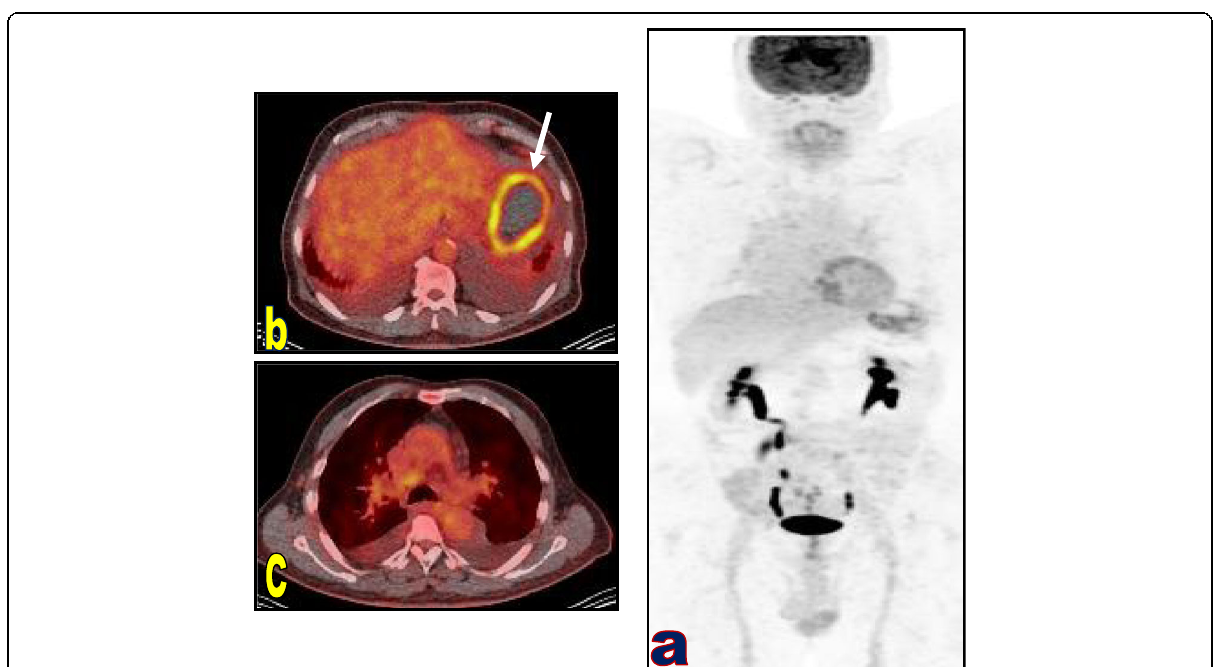
Fig. 6 3D MIP ( a ) and axial fused PET/CT images ( b and c ) for a 67-year-old male patient with history of surgically resected gastric adenocarcinoma and splenectomy. No FDG-avid lesions at gastroesophageal anastomotic site, while splenectomy operative bed shows a localized collection with marginal increase of FDG activity and air loculi within (arrow), low-grade mediastinal lymph nodes as well as bilateral moderate pleural effusion and mild pelvic ascites demonstrating low-grade FDG activity. Final diagnosis confirmed by histopathology and radiological follow-up for splenectomy bed collection complicated with infection (an example of false-positive